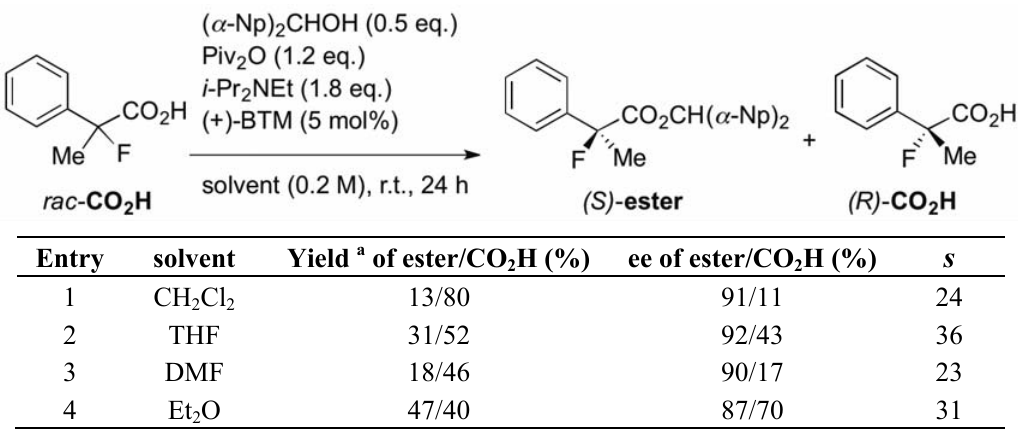
Table 1. Screening of